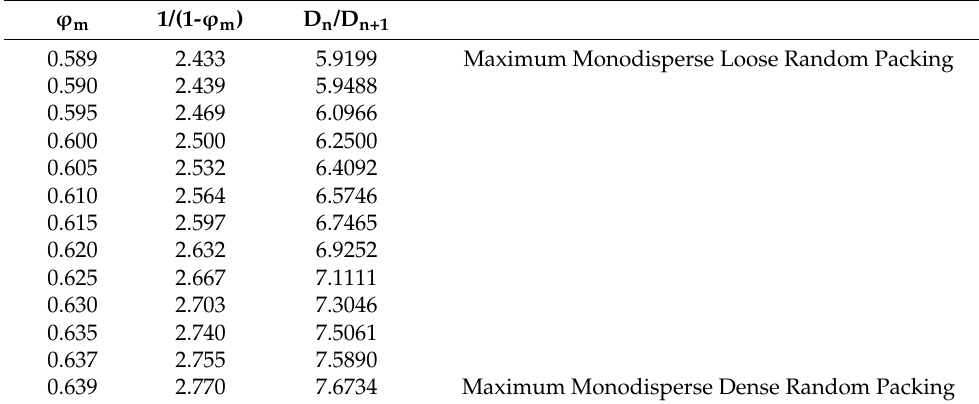
Table 4. Optimum ratio between particle